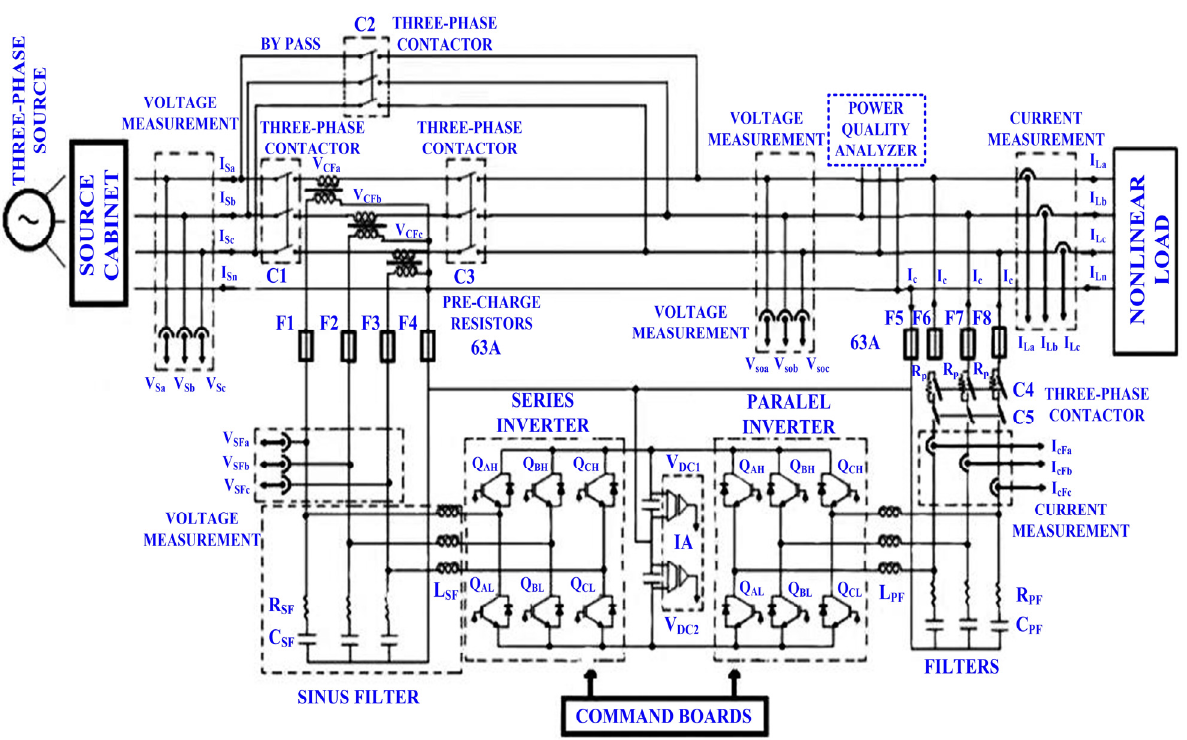
Figure 1. UPQC system architecture [25].